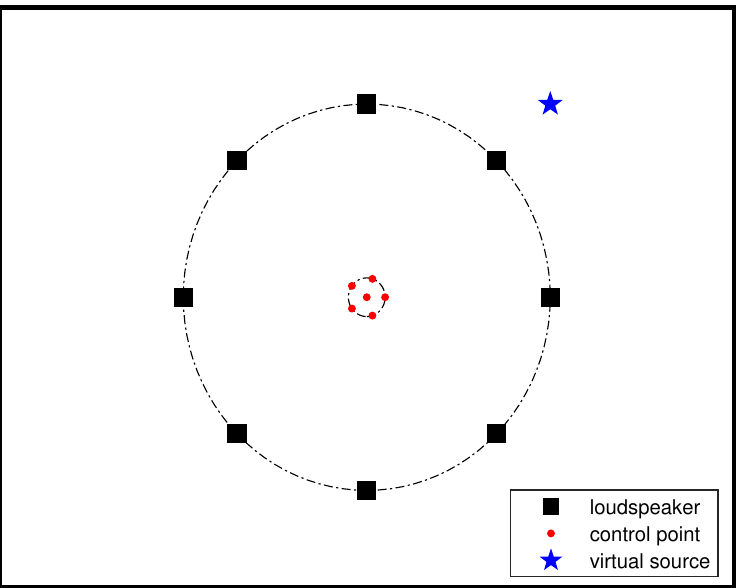
Figure 1. Simulation setup: 8 loudspeakers locate on a circle with a radius of 2 m, which are denoted by the black squares. The red dots denote the controlled points. The blue star indicates the location of the virtual sound